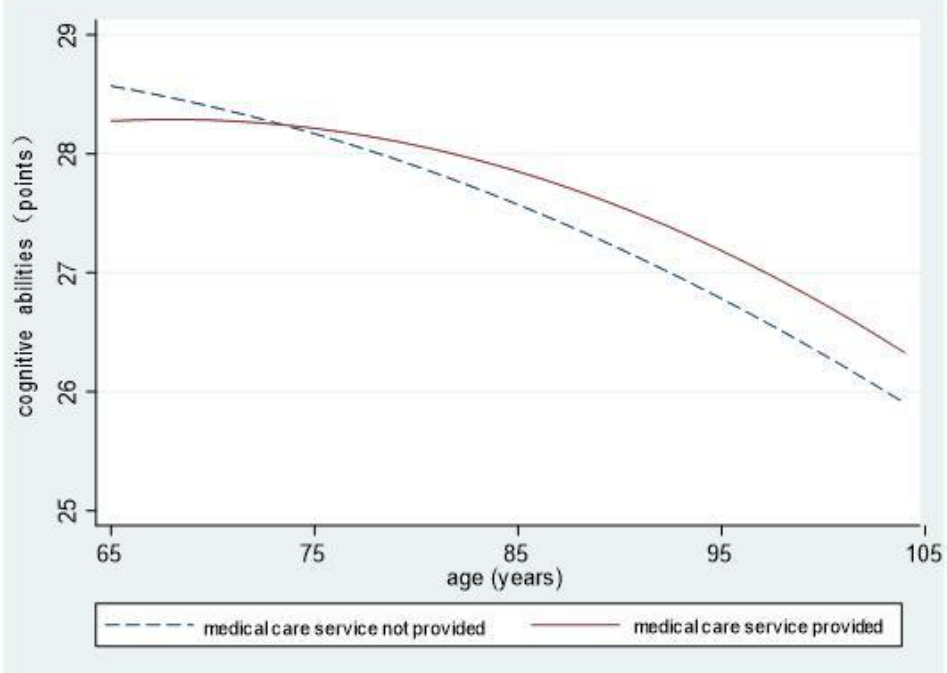
Figure 4. The influences of communities providing medical care services on cognitive